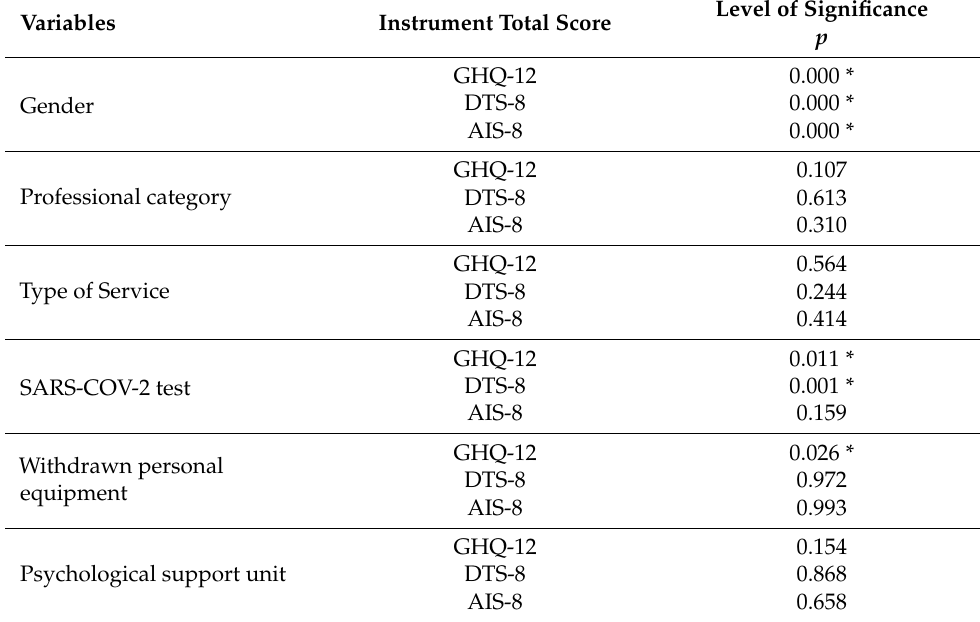
Table 4. Inferential analysis: analysis of variance (ANOVA).